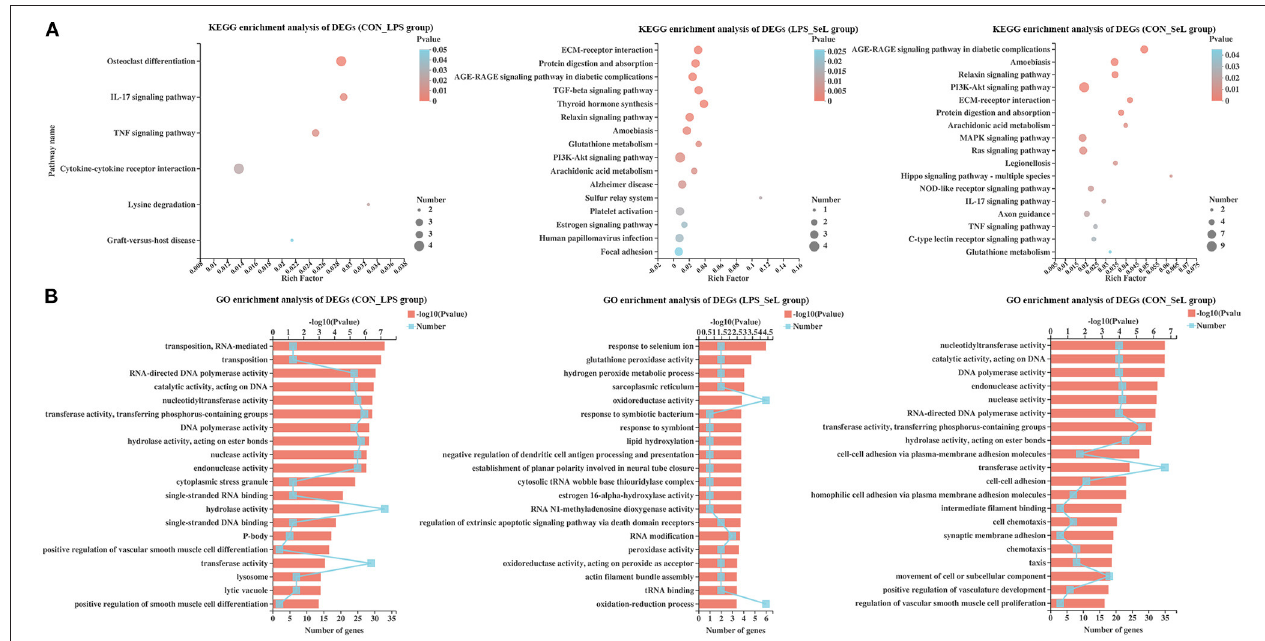
FIGURE 1 | KEGG and GO enrichment analysis of DEGs. Enriched bubble chart showing the enrichment of the KEGG pathway in the CON_LPS, LPS_SeL, and CON-SeL groups (A) . X-axis represented the enrichment ratio, and Y-axis represented the top 20 KEGG pathways. Number: bubble size represented the number of genes annotated to a KEGG pathway. Pvalue: color indicated the enriched p -value. Enriched bar chart showing the enrichment of the GO pathway in the CON_LPS, LPS_SeL, and CON-SeL groups (B) . The length of the X-axis column represents the p -value. The value of the box on the fold line above X is the number of DEGs annotated to the GO